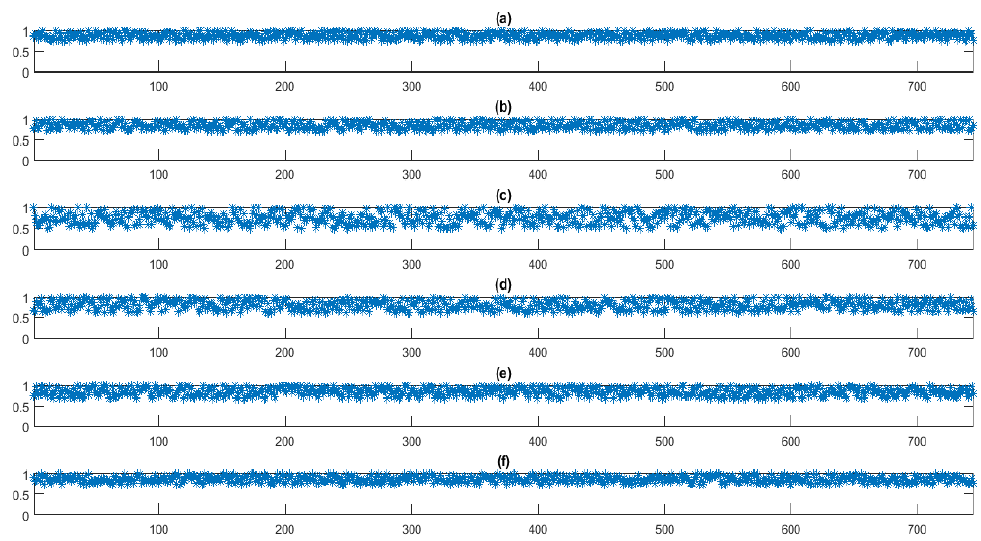
Figure 6. Max ( ) for (a). MS-SEMI-K (1) model, (b). MS-SEMI-K (2) model, (c). MS- SEMI-K (3) model, (d). MS-SEMI-K (4) model, (e). MS-SEMI-K (5) model, (f). MS-SEMI-K (6)